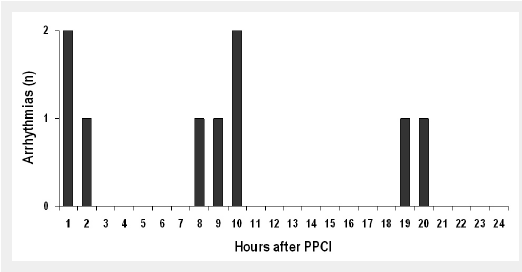
Time of occurrence of post-procedural life-threatening arrhythmias in patients with ST-segment elevation myocardial infarction undergoing primary percutaneous coronary intervention (PPCI). In addition, a single episode of sustained ventricular tachycardia occurred on the 4 th post-procedural day in a patient with hypokalemia (not